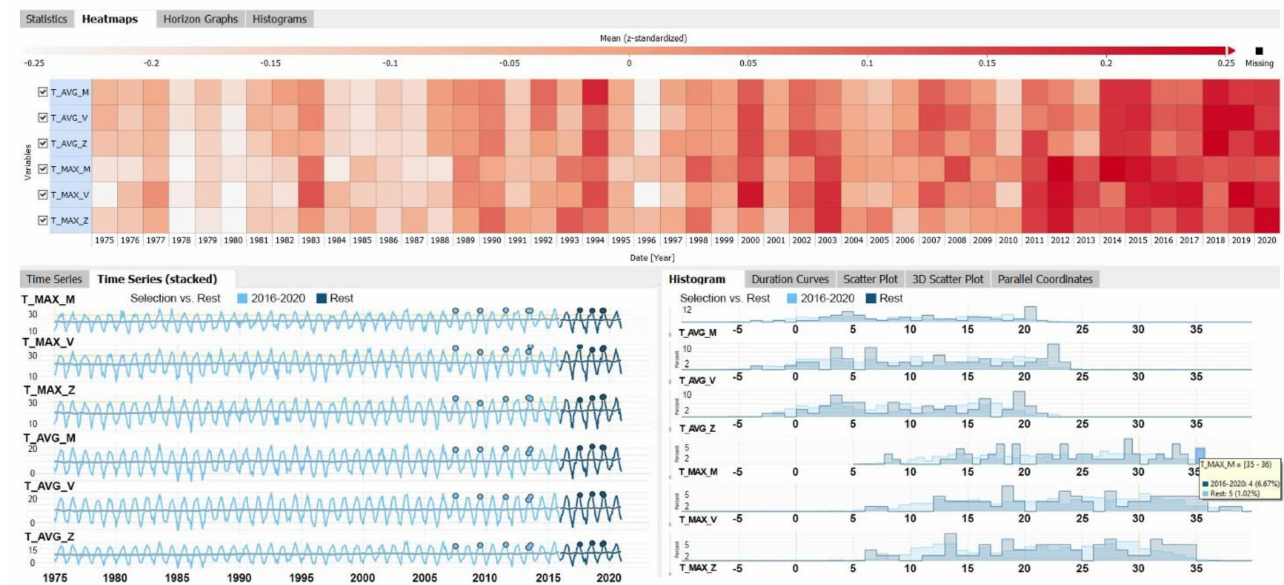
Figure 1. Composite view of temperature time-series (average and maximum values): heatmap view ( up ), time-series distribution ( down left ), frequency distribution ( down right ). Table 2. Total number of missing timestamps (number of hours) in the data for each parameter. Long-Term Parameters